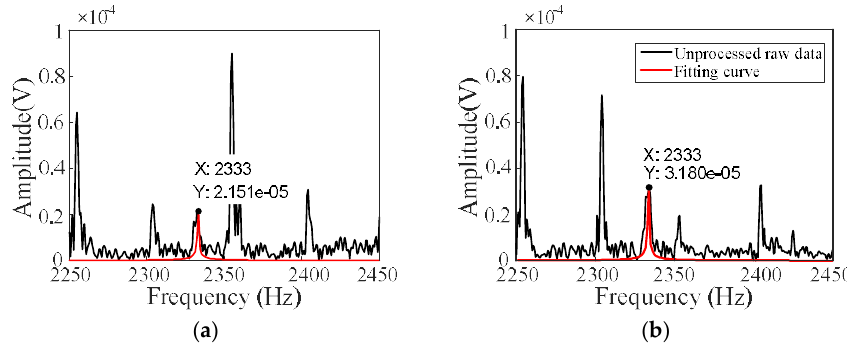
Figure 8. The spectrum of the FID signal; the black curve represents the detection data and the red curve represents the fitting data. ( a ) Spectrum of FID signal when R m = 57 kΩ; ( b ) Spectrum of FID signal when R m = 10 kΩ.